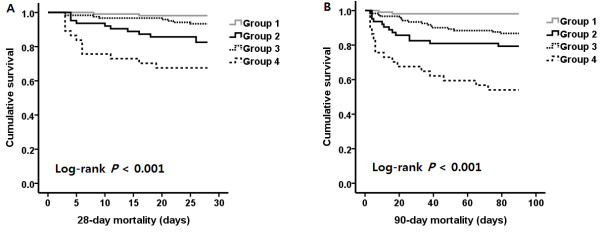
Kaplan-Meier plots for cumulative 28-day (A) and 90-day (B) survival according to baseline red blood cell distribution width (RDW) value and ΔRDW72hr-adm (ΔRDW72hr-adm, RDW at 72 hours – RDW at baseline). Group 1 included patients with RDW levels in the reference range (normal RDW level) at baseline and ΔRDW72hr-adm ≤0.2%, group 2 comprised patients with increased RDW at baseline and ΔRDW72hr-adm ≤0.2%, group 3 included patients with normal RDW at baseline and ΔRDW72hr-adm >0.2%, and group 4 was made up of patients with increased RDW at baseline and ΔRDW72hr-adm >0.2% (P <0.001 by log-rank test for overall comparison among groups in both 28-day and 90-day cumulative survival plots).